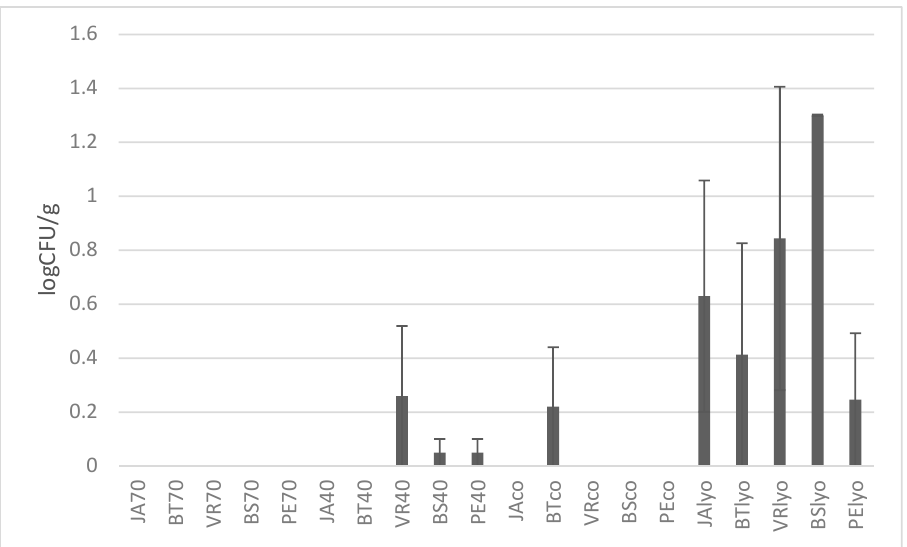
Figure 2. Determination of moulds in individual varieties depending on drying method (70 °C, 40 °C, combined, lyophilised) in log CFU/g. Varieties: JA—Jakubské, BT—Beauty seedless, PE—Perlette, VR—Vrboska, BS—Bezsemenné. CFU—colony forming units.